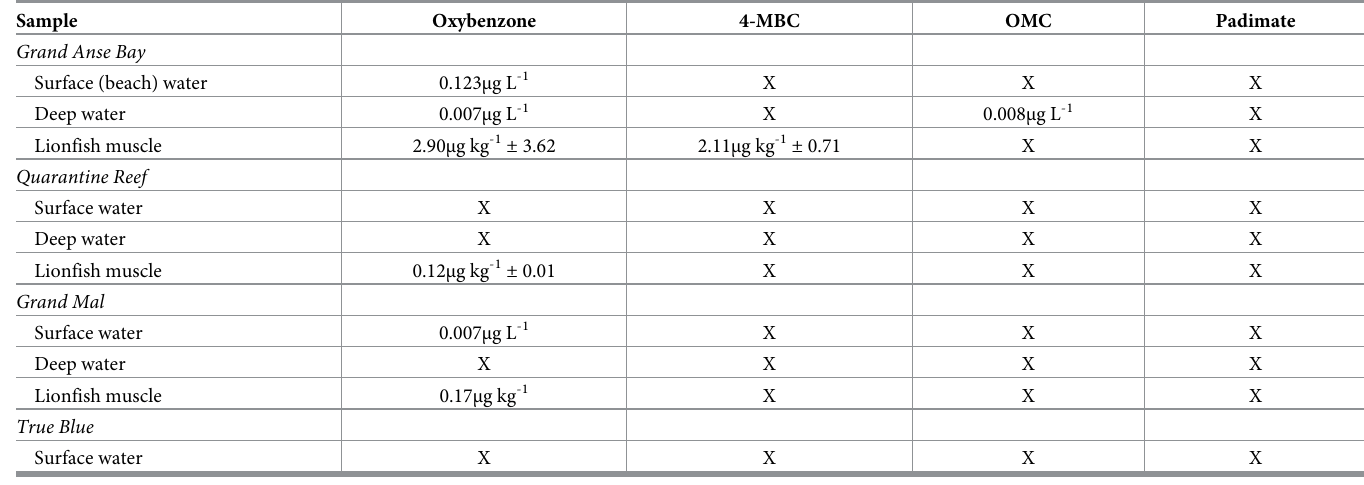
X–Indicates that contaminants were not detected or detected below laboratory